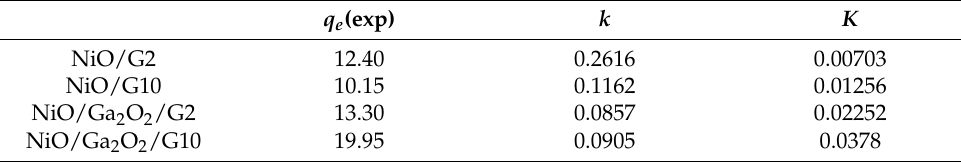
Figure 9. Effect of the contact time on the degradation capacity of CR on NiO/G2, NiO/G10, NiO/Ga 2 O 2 /G2, and NiO/Ga 2 O 2 /G10 nanocomposites.